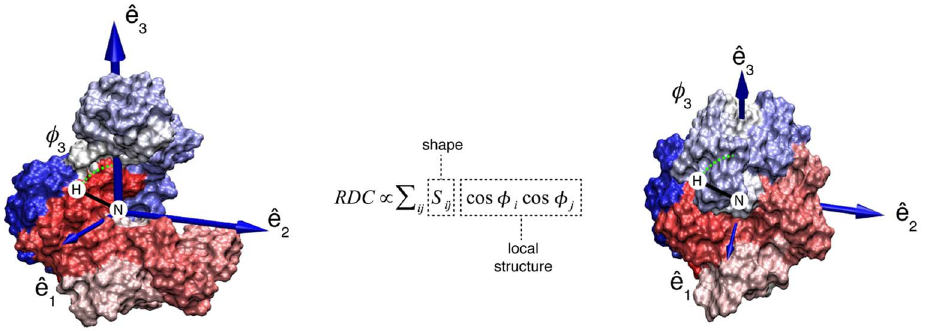
Figure 1. RDCs report on molecular shape. RDCs depend on the geometry of the relevant nuclei ( Q i ) and on the degree and direction of alignment ( S ) of the molecule with respect to the laboratory frame. S is a 3 6 3 symmetric and traceless matrix, which contains information on the shape of the molecule. Q i is the angle between the inter-nuclear vector and axis i of the molecular reference frame where S is defined. The direction and magnitude of alignment are shown as eigenvectors (eˆ i , i=1, 2, 3) and eigenvalues (vector size, not in scale) for AK e in the open (left) and closed (right) states.